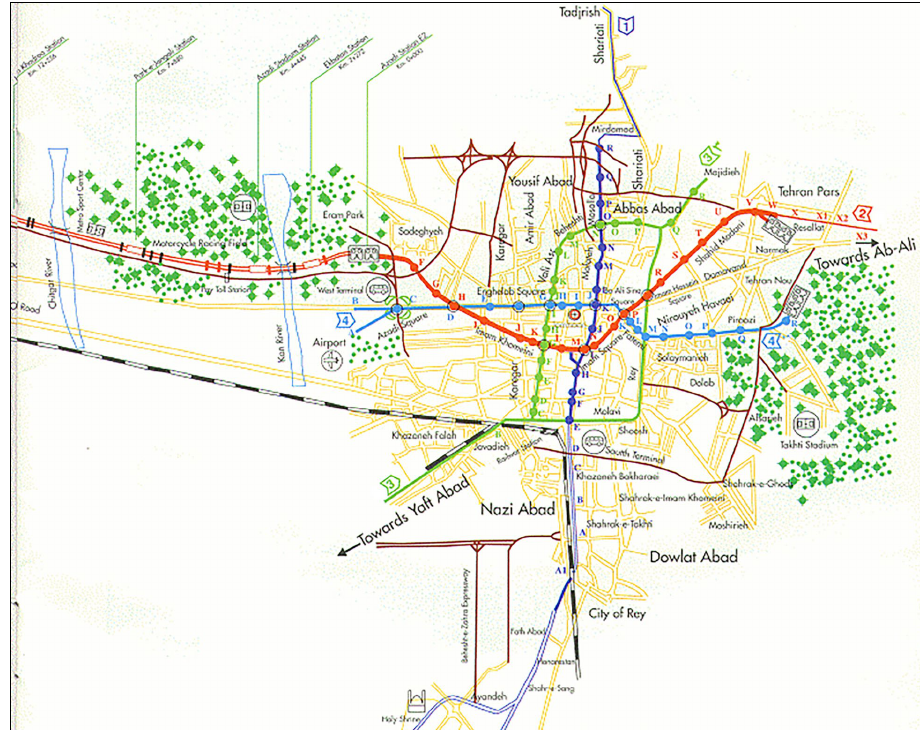
Fig. 2. Tehran metro